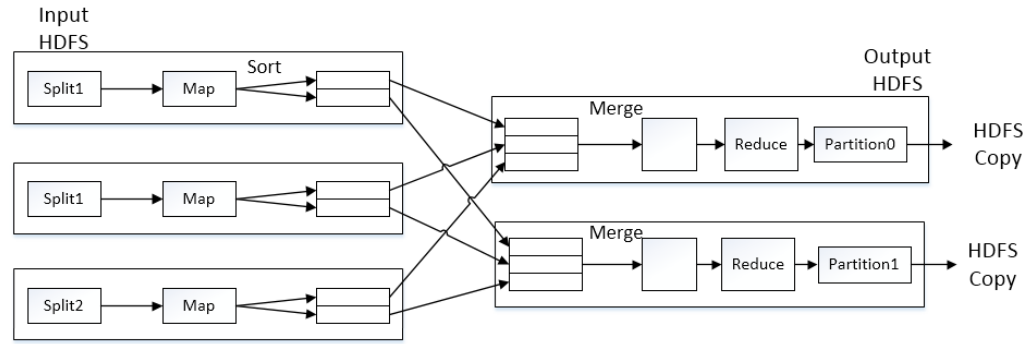
Figure 2. Overview of MapReduce process framework.